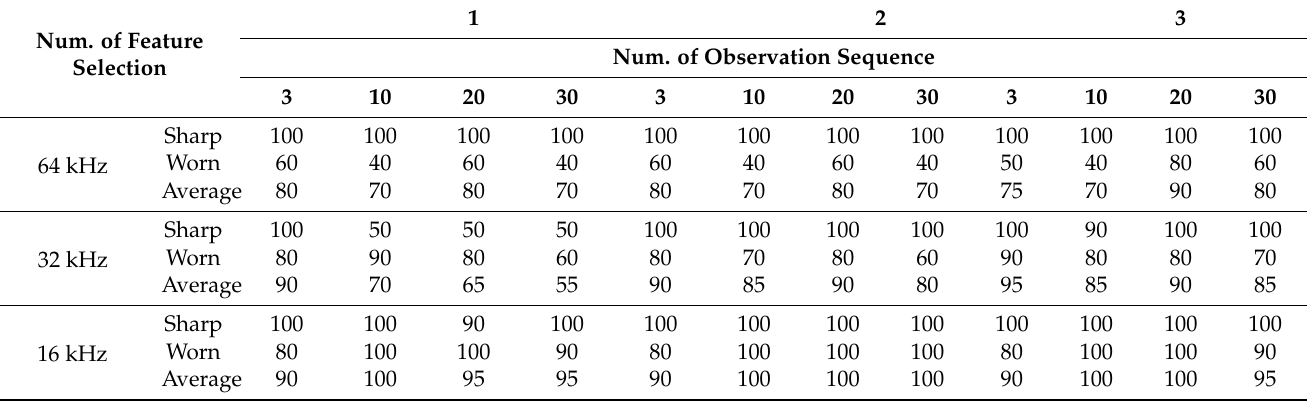
Table 7. Classification rate with different feature bandwidths and observation sequences (spindle AE signals). Unit: %.